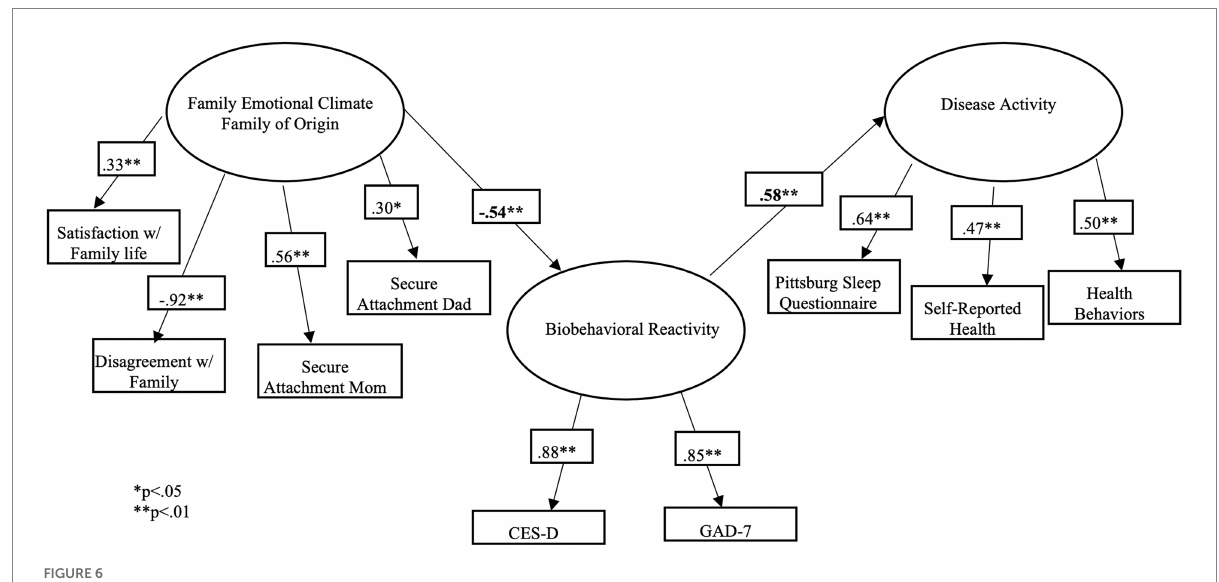
FIGURE 6 Structural equations model